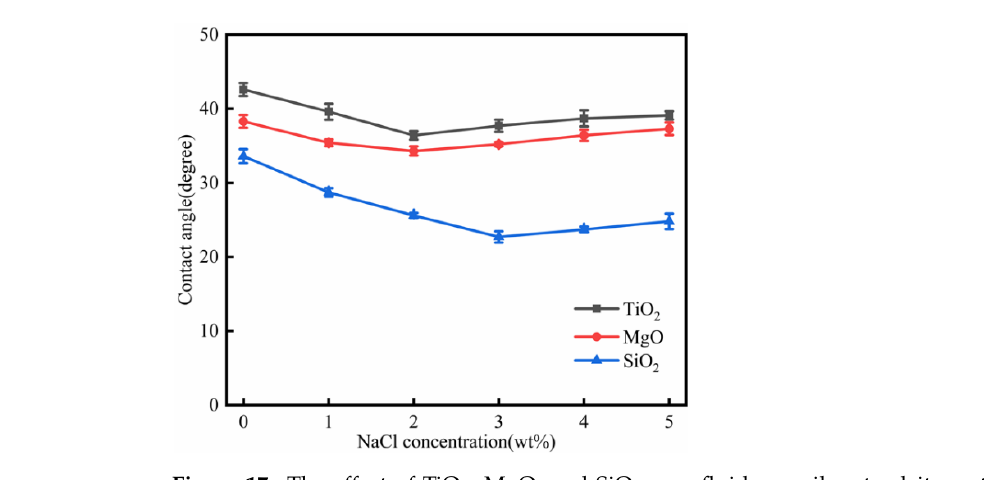
Figure 19. Zeta potential of ( a ) 500 ppm surfactants; ( b ) 0.1 wt% nanofluids; ( c ) 500 ppm surfactant and 0.1 wt% nanofluid hybrid solutions.